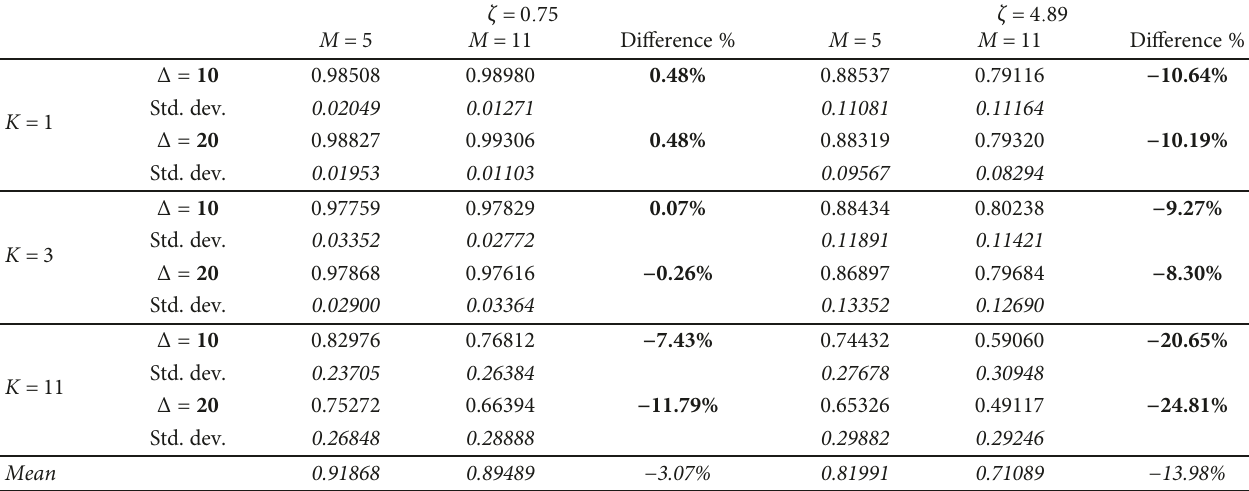
Table 1: Results for M = 5 and M = 11 with density =1. ∗